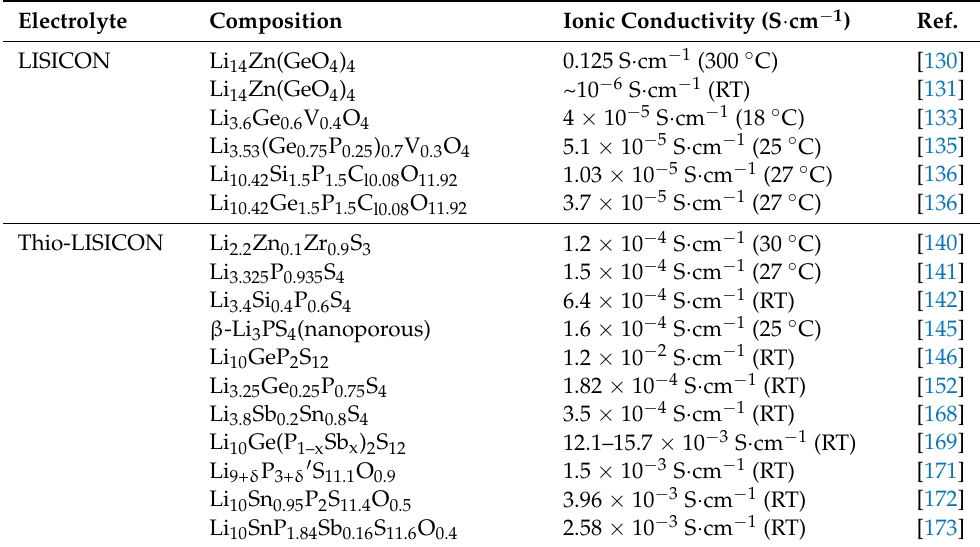
Table 1. Cont. Electrolyte Composition Ionic Conductivity (S · cm − 1 ) Ref.